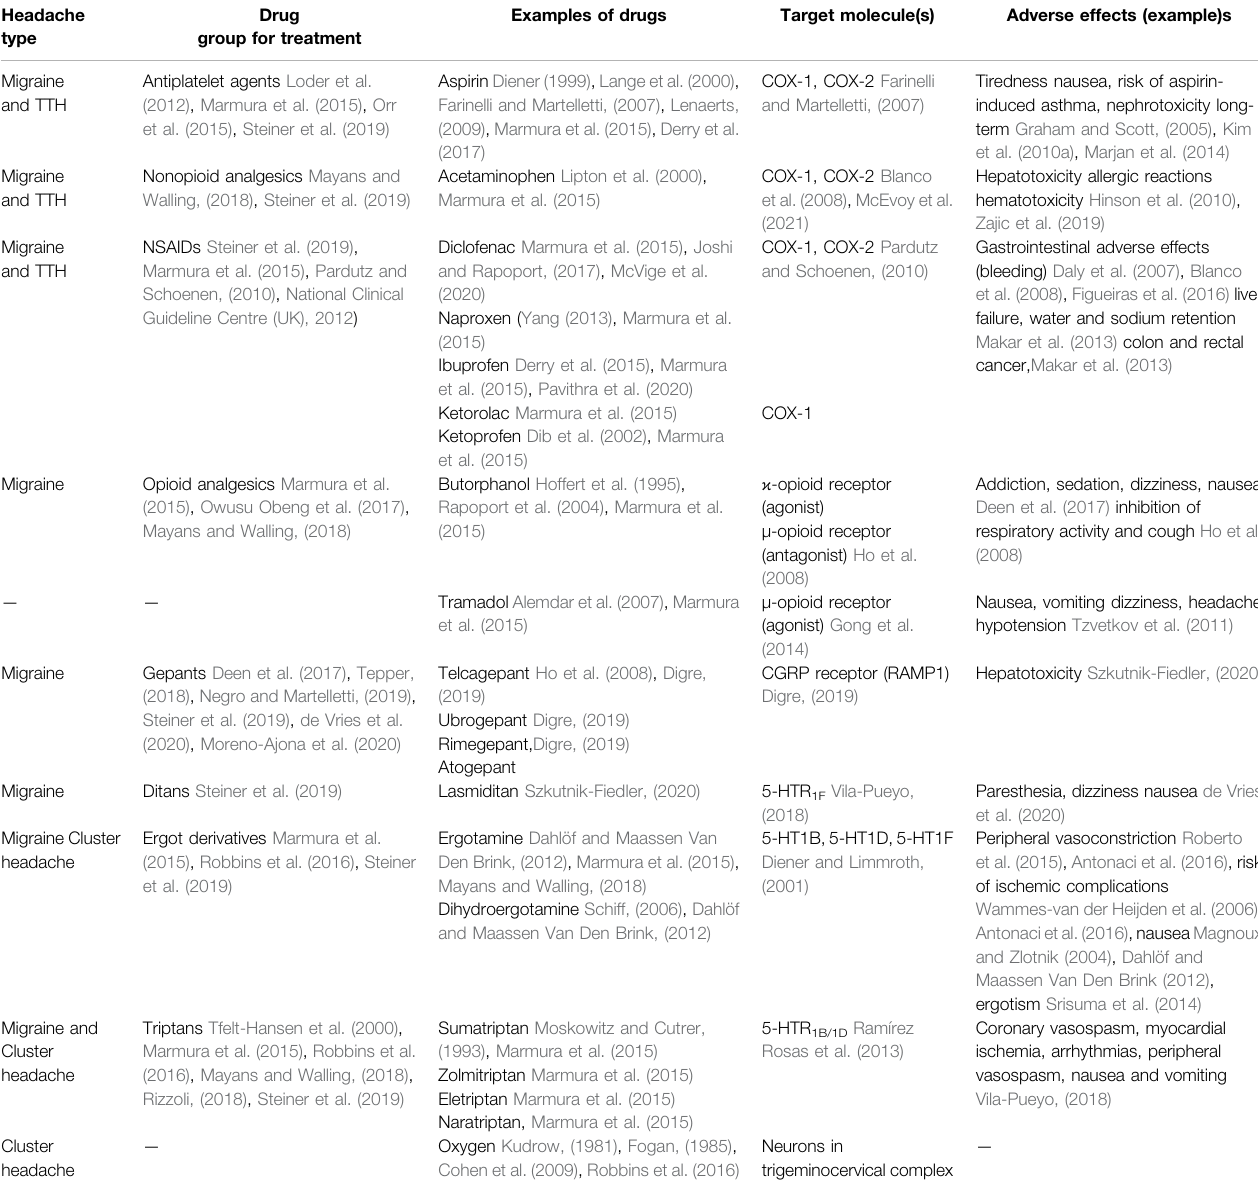
Examples of drugs Target molecule(s) Adverse effects (example)s